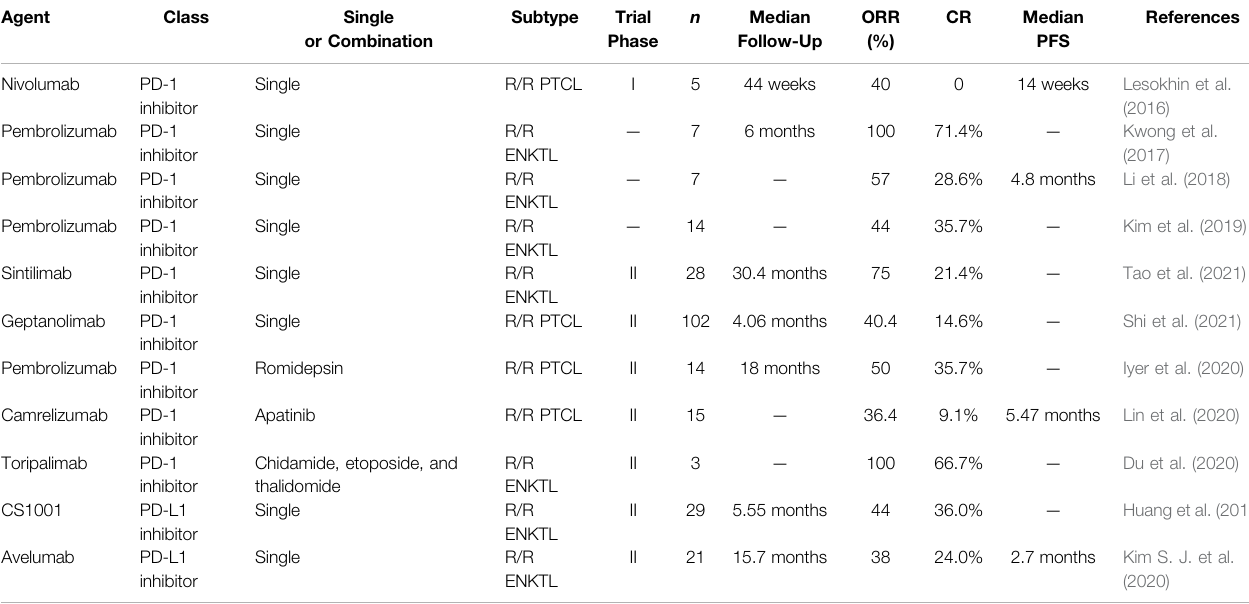
TABLE 1 | Results of major clinical studies of PD-1/PD-L1 inhibitors for R/R